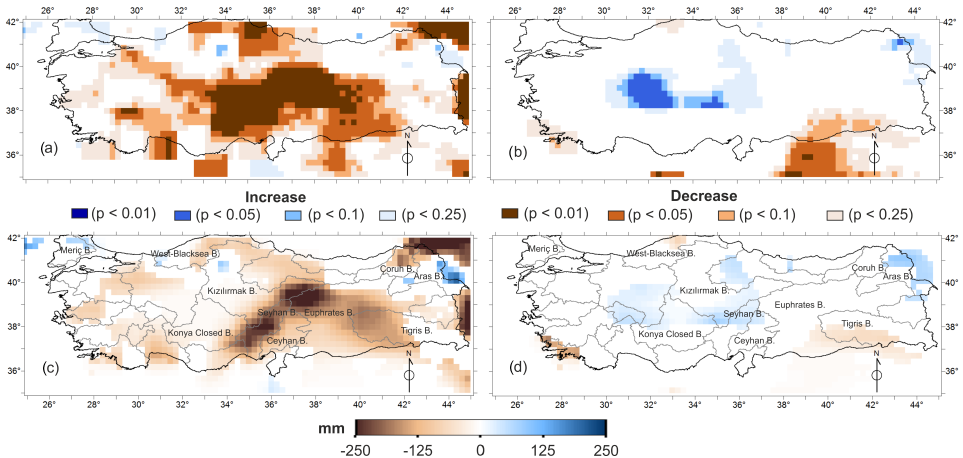
Figure 10. The distribution of the presence and the direction of runoff trends by (a) ERA-Interim and (b) Interim/Land. The magnitudes of 32-year total runoff trends by (c) ERA-Interim and (d) Interim/Land. The polygons in (c) and (d) delineate the 26 water basins in the country.